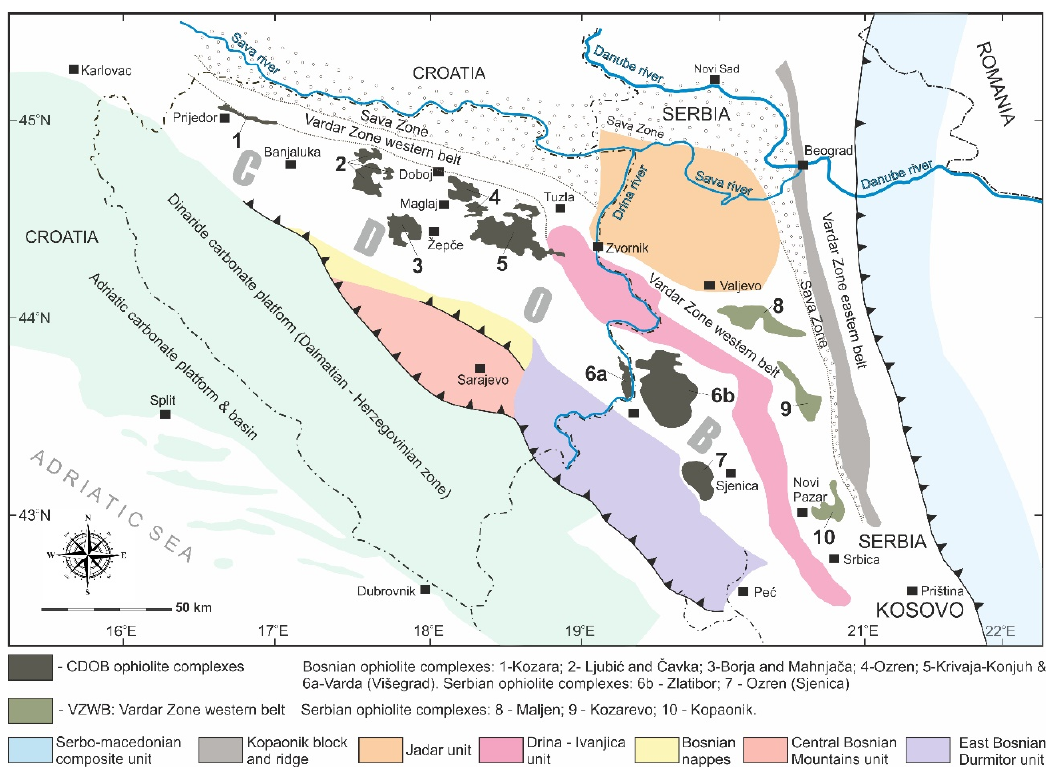
Figure 1. Ozren Massif (4) in Central Dinaridic Ophiolite Belt (after [31,32], modified).